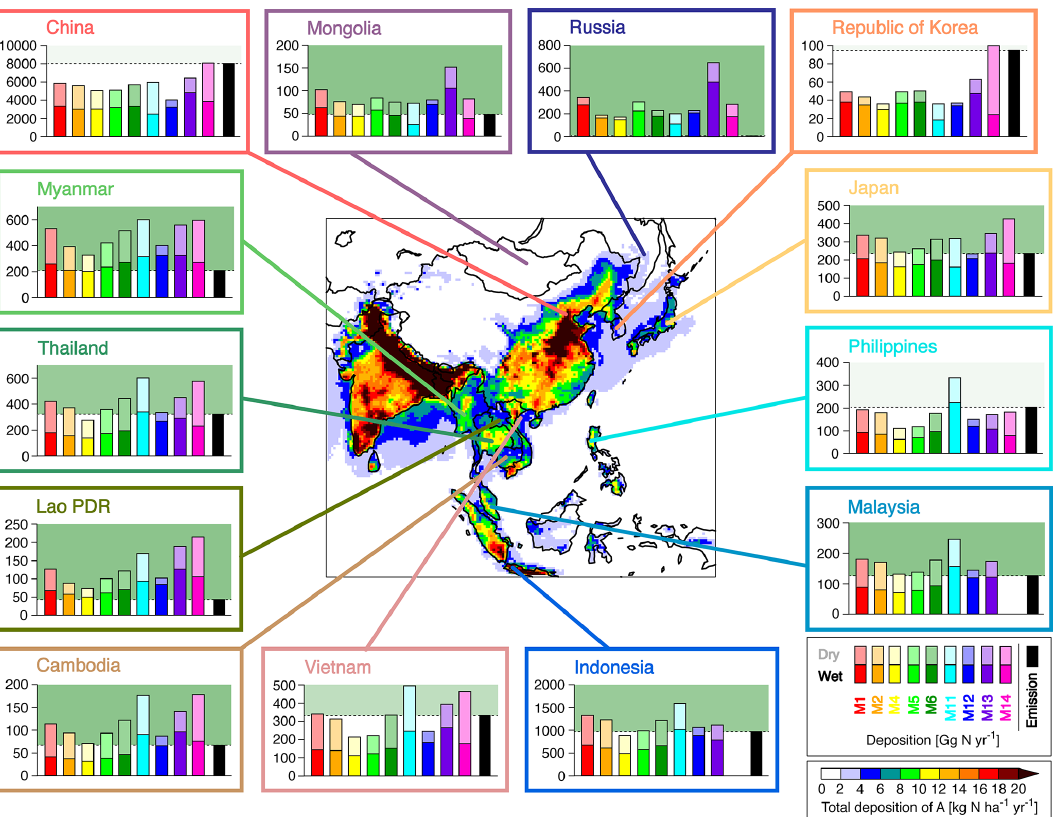
Figure 11. Map of the annual accumulated total A deposition over Asia. The cumulative bar graphs show dry deposition (light colors) and wet deposition (dark colors), with different colors representing different models and black representing the amount of anthropogenic NH 3 emissions. The background green areas of the graphs indicate the excess of total deposition compared to emissions, and their transparency is based on the number of models making this prediction (i.e., bolder colors indicate that more of the nine models simulated the excess).